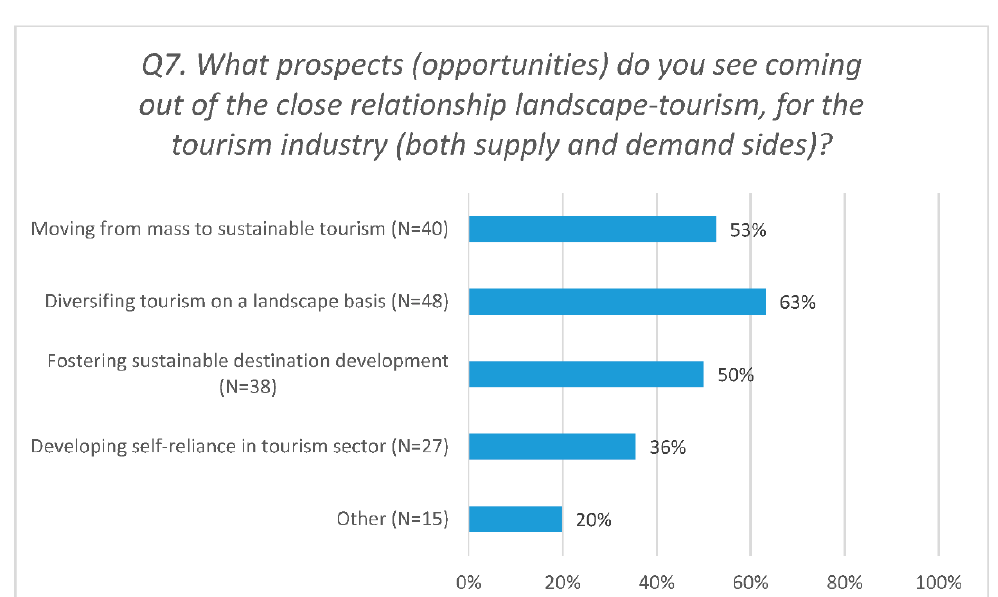
Figure 4. Perceptions of what a landscape of tourism encompasses.